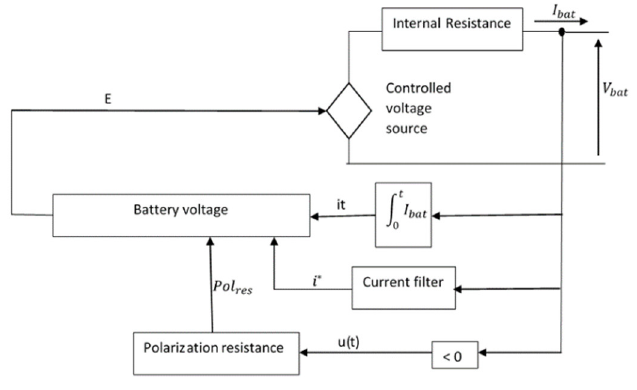
Figure 7. Model of Li-ion [25].